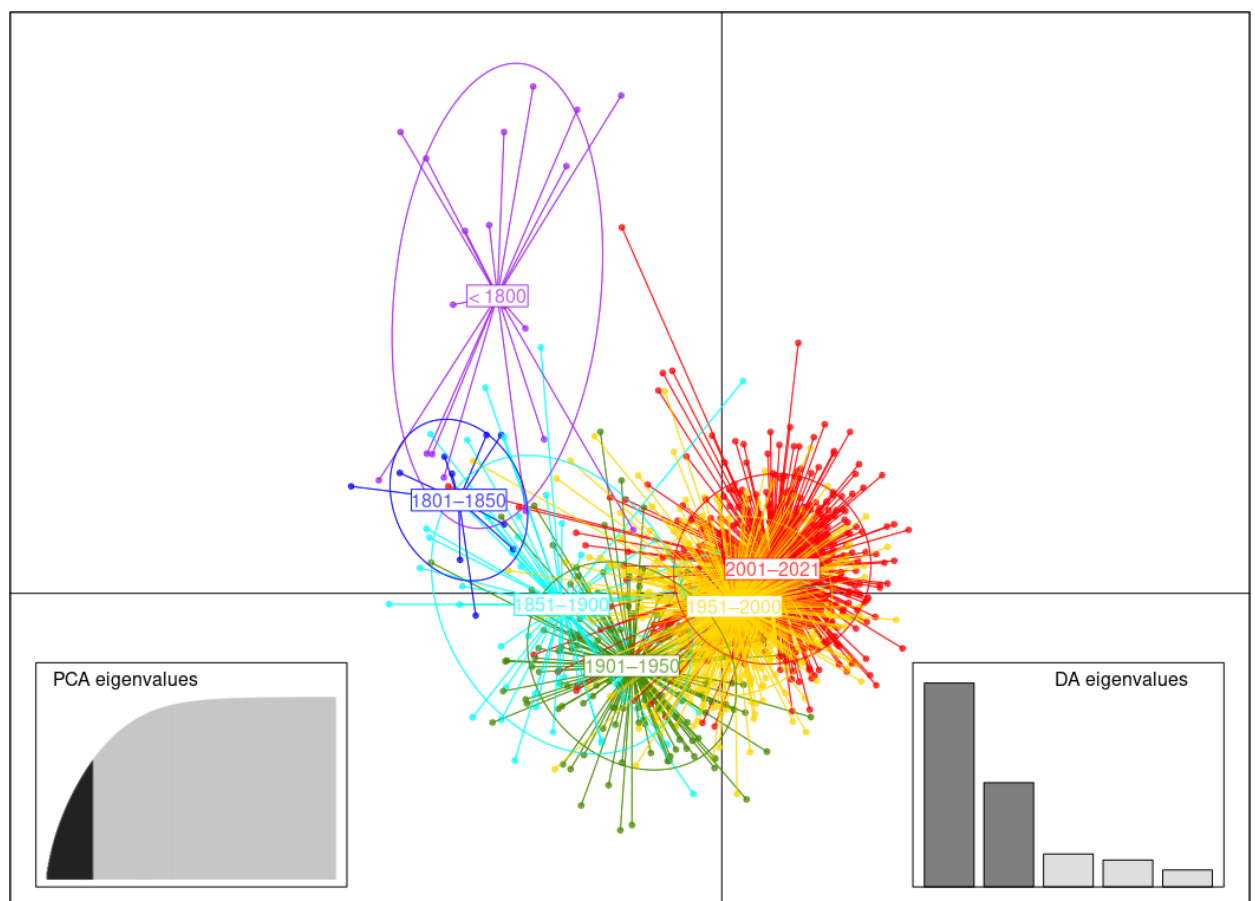
Figure 7. Discriminant analysis of principal components (DAPC) for the germplasm of 1219 potato accessions of 50-year breeding groups. The axes correspond to the first two linear discriminants (LD). Each ellipse represents a 50-year breeding cluster ([<1800], [1801–1850], [1851–1900], [1901–1950], [1951–2000], [2000–2021]), and each point represents an individual.